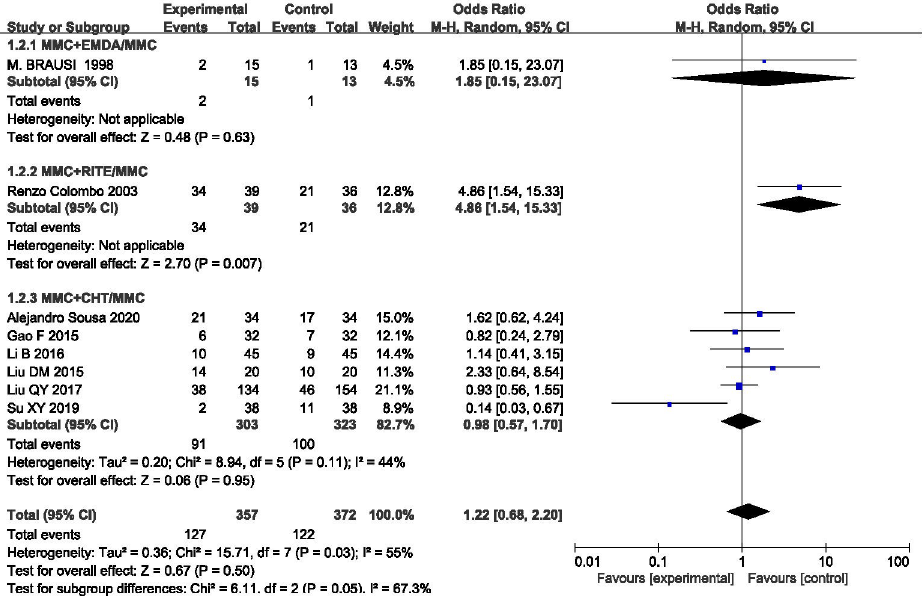
Fig 6. Forest plots for the meta-analysis of the side-effect profiles by the different